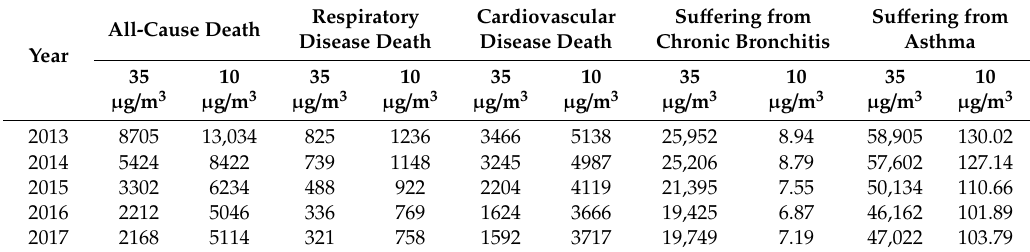
Table 5. Excess health e ff ects when PM 2.5 drops to 35 µ g / m 3 and 10 µ g / m 3 (unit: